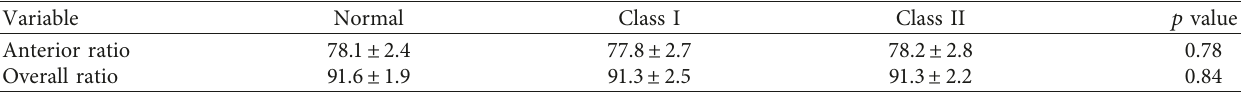
Table 4: Comparison of tooth size and Bolton’s anterior and overall ratios as a function of Angle’s malocclusion.